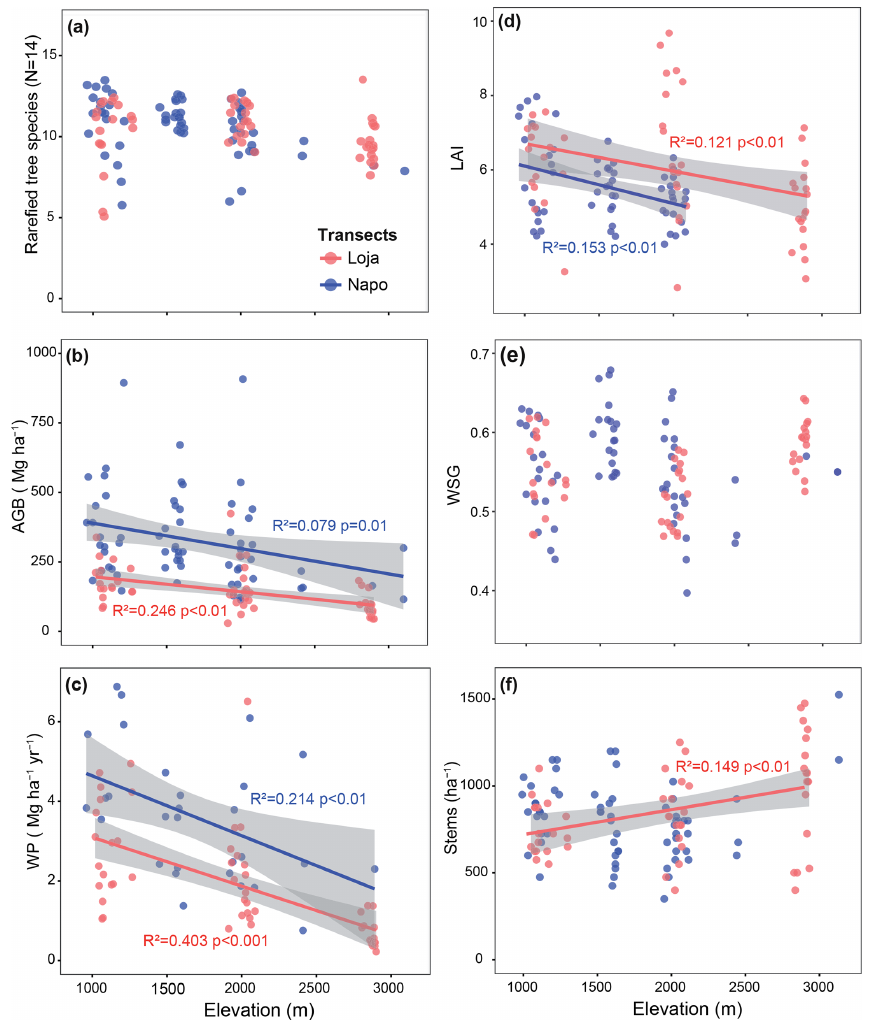
Figure 2. Variation in tree diversity (a) , aboveground biomass (b) , wood production (c) , LAI (d) , wood specific gravity (e) and stem density (f) along the two studied forest transects (red dots: Loja transect; blue dots: Napo transect). The number of plots available for a given parameter and transect varies as not all parameters were measured in all plots ( a : Loja 54 plots, Napo 64 plots; b : 54, 66; c : 54, 29; d : 53, 60; e : 54, 66; f : 54, 66). Data presented in (b) , (c) , (e) and (f) were compiled from Unger et al. (2012), Leuschner et al. (2013) and Kessler et al. (2014); data from the Napo transect in (d) are from Unger et al.